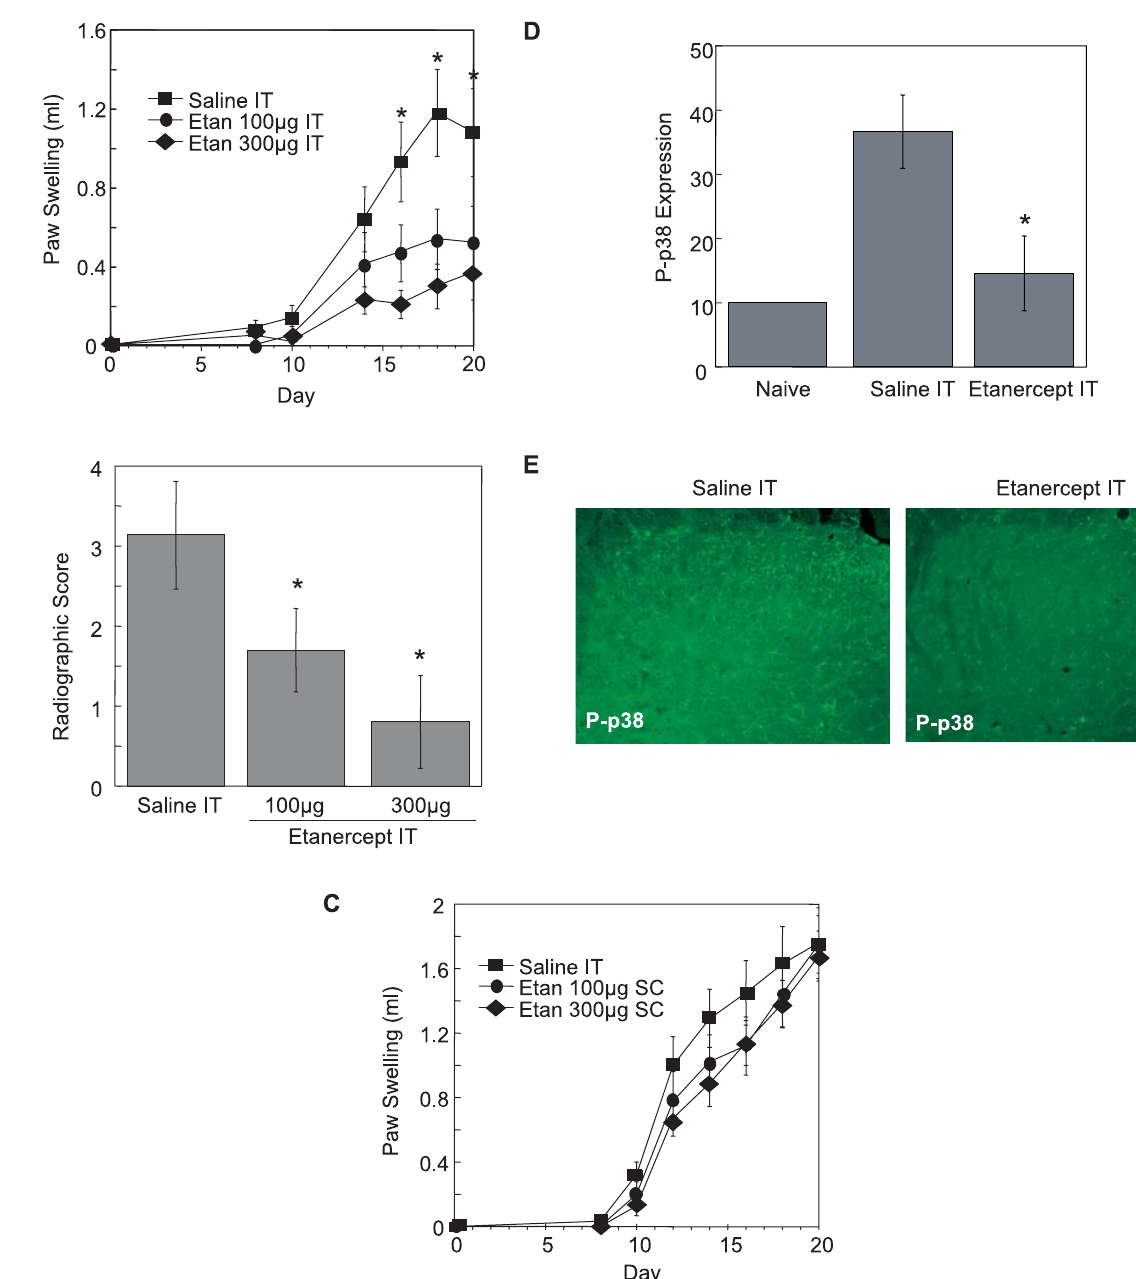
Figure 4. Effect of IT Etanercept on Adjuvant Arthritis Rats were immunized with CFA on day 0 and treated with IT etanercept (100 or 300 l g q.o.d.) beginning on day 1. (A) IT etanercept (Etan) significantly decreased paw swelling (* p ¼ 0.001 for IT saline compared with either IT etanercept group) ( n ¼ 6/group). (B) IT etanercept significantly decreased joint damage (by radiographic score; * p ¼ 0.026 for IT saline compared with either IT etanercept group) ( n ¼ 6/ group). (C) Similar doses of etanercept given systemically (SC) beginning on day 1 had minimal effect on paw swelling ( p ¼ 0.398 for IT saline compared with either etanercept group) ( n ¼ 6/group). (D and E) IT etanercept decreased spinal P-p38 staining in adjuvant arthritis. Rats were immunized on day 0 and injected IT with 300 l g of etanercept or vehicle on days 7 and 10. They were sacrificed on day 11 and P-p38 was determined by Western blot (D) and immunofluorescence (E). Western blot data were normalized to GAPDH and demonstrated significantly lower levels of P-p38 after IT etanercept treatment ( n ¼ 6 for etanercept, 4 for saline, and 2 for naı¨ve). * p ¼ 0.023 compared with IT saline. DOI: